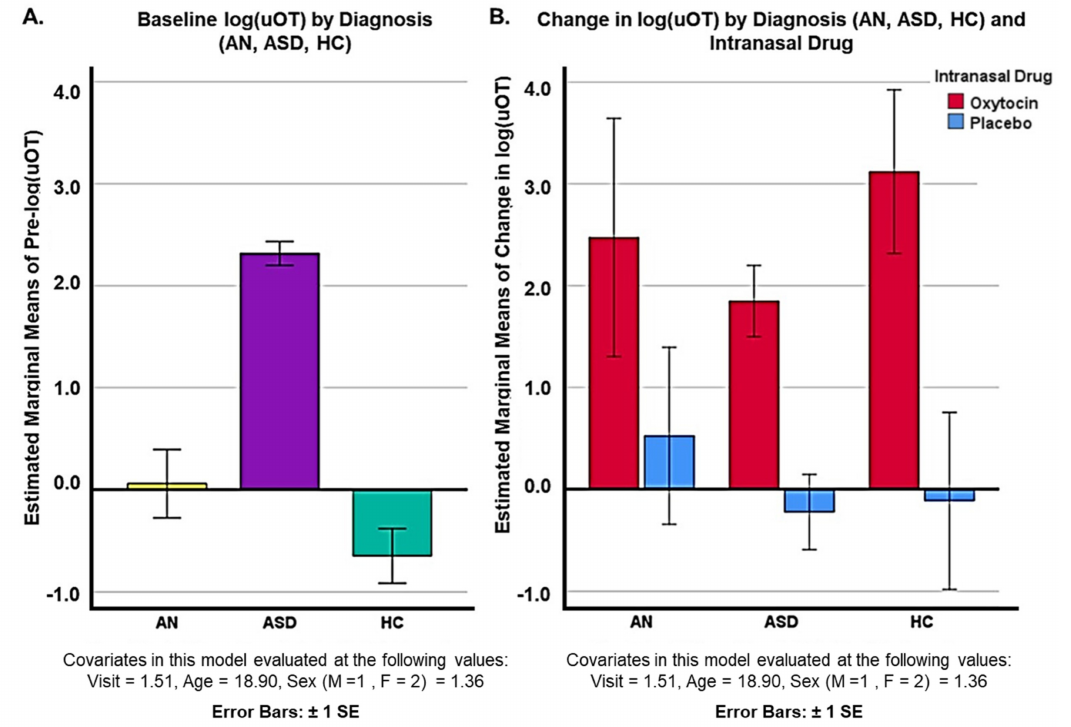
Figure 3. Unblinded comparison of ( A ) baseline uOT levels for diagnostic groups (AN, ASD, and HC) groups and ( B ) change in log(uOT) for diagnostic groups (AN, ASD, and